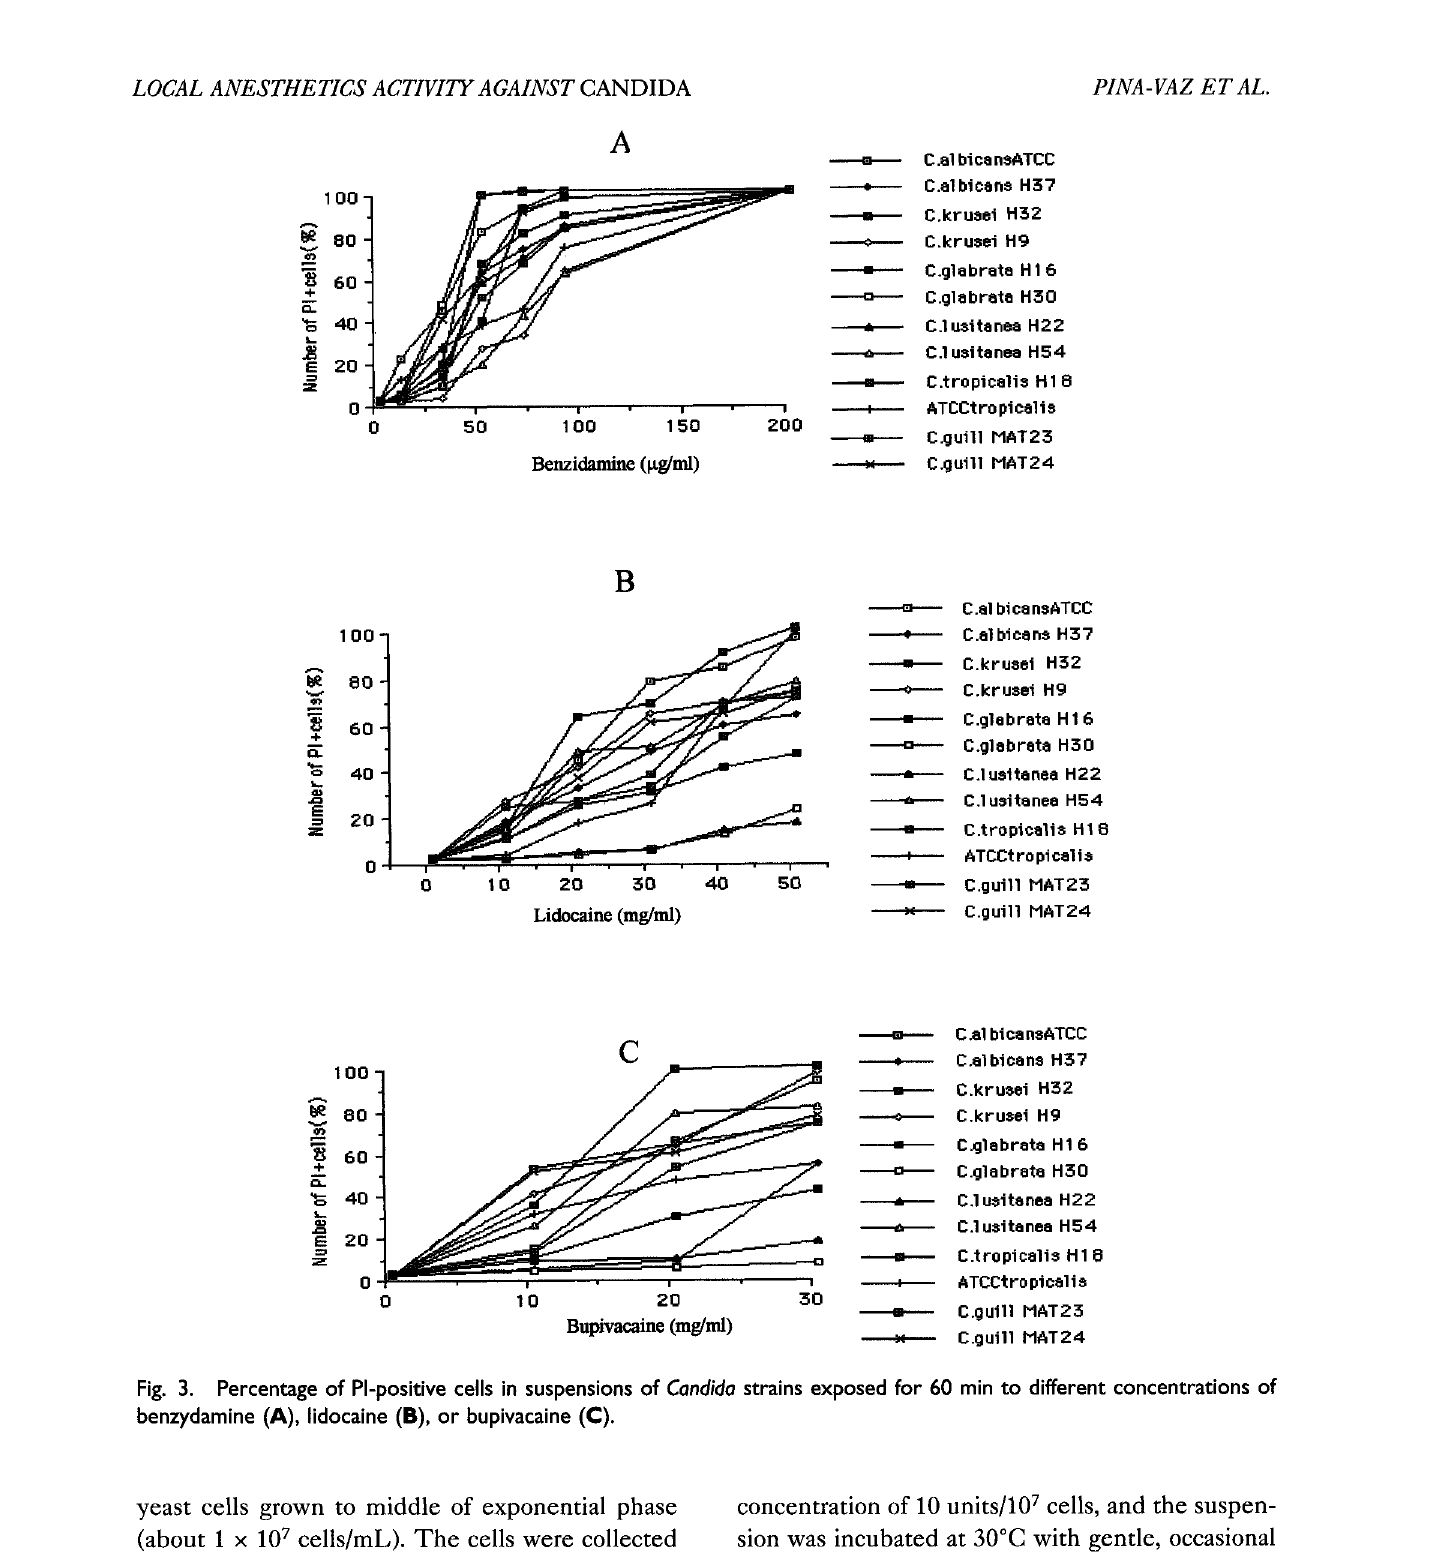
Fig. 3. Percentage of Pl-positive cells in suspensions of Candida strains exposed for 60 min to different concentrations of benzydamine (A), lidocaine (B), or bupivacaine